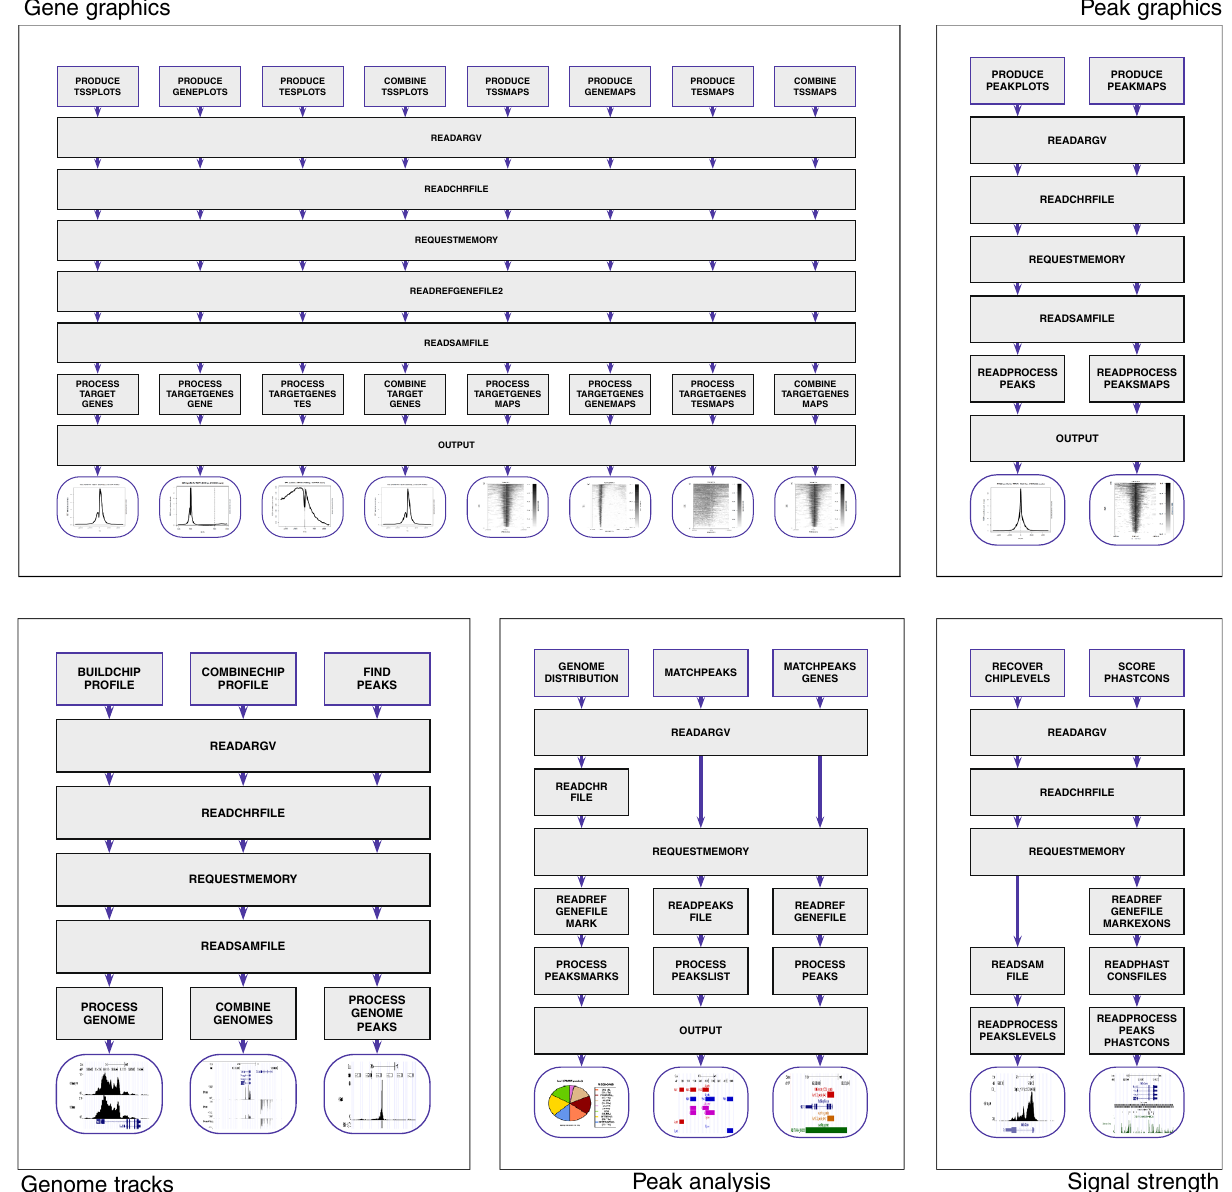
Figure 1. Modular architecture of SeqCode. Diagram of subroutines implemented in SeqCode to perform multiple tasks. Functions were classified depending on the object of analysis: genes, genomic regions or peaks, genome tracks, and signal levels. Functions are represented as boxes; arrows indicate the dataflow of each